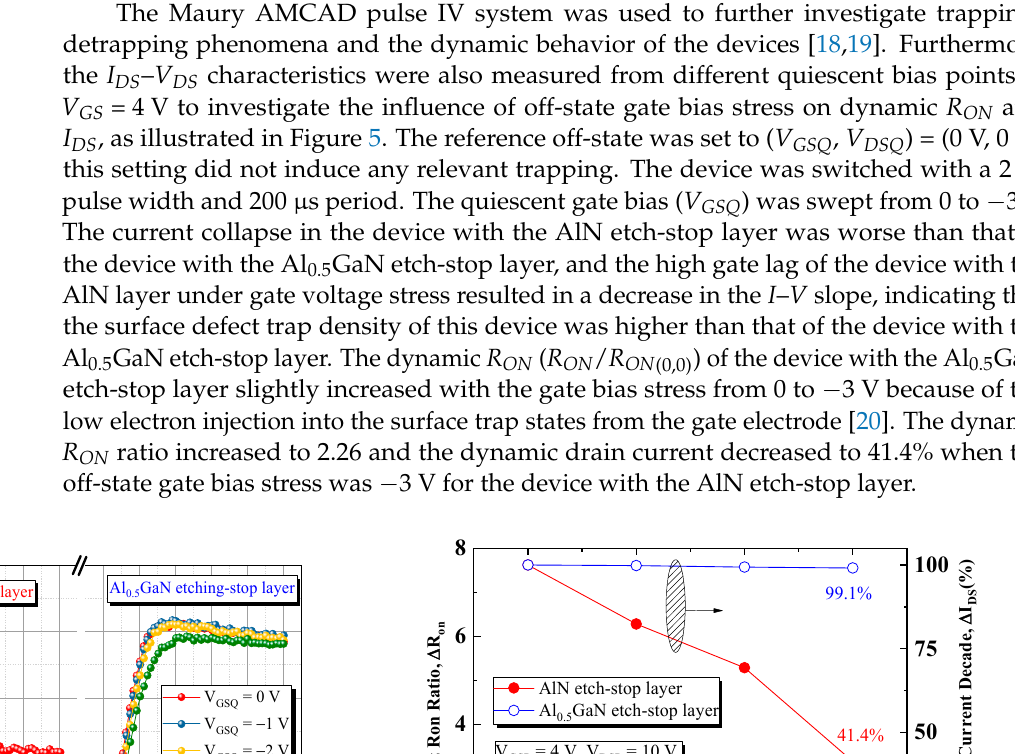
Figure 4. ( a ) Gate leakage characteristics and ( b ) off-state breakdown voltage measurement of both devices.